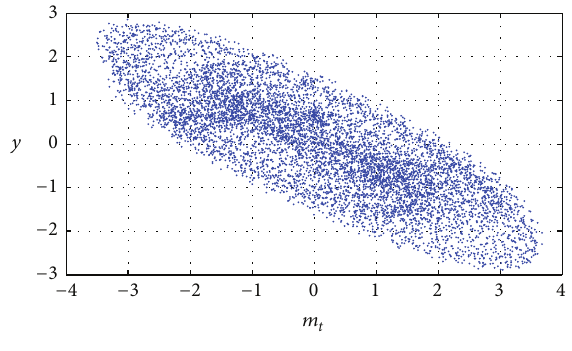
Figure 17: Poincare map with 𝜔 = 0 .